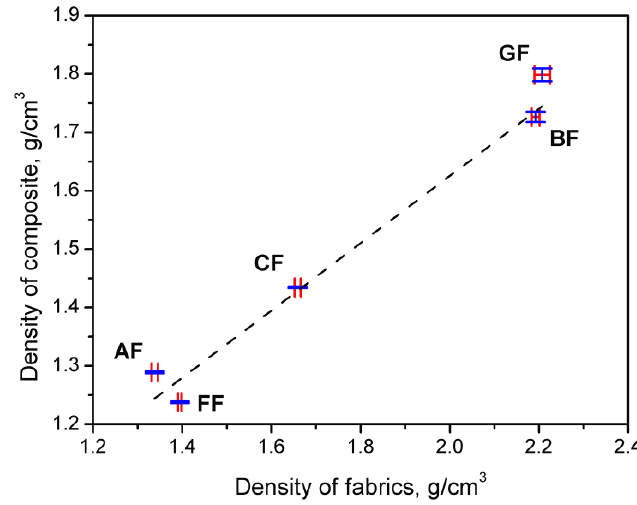
Figure 5. The density of composites and density of fabrics.